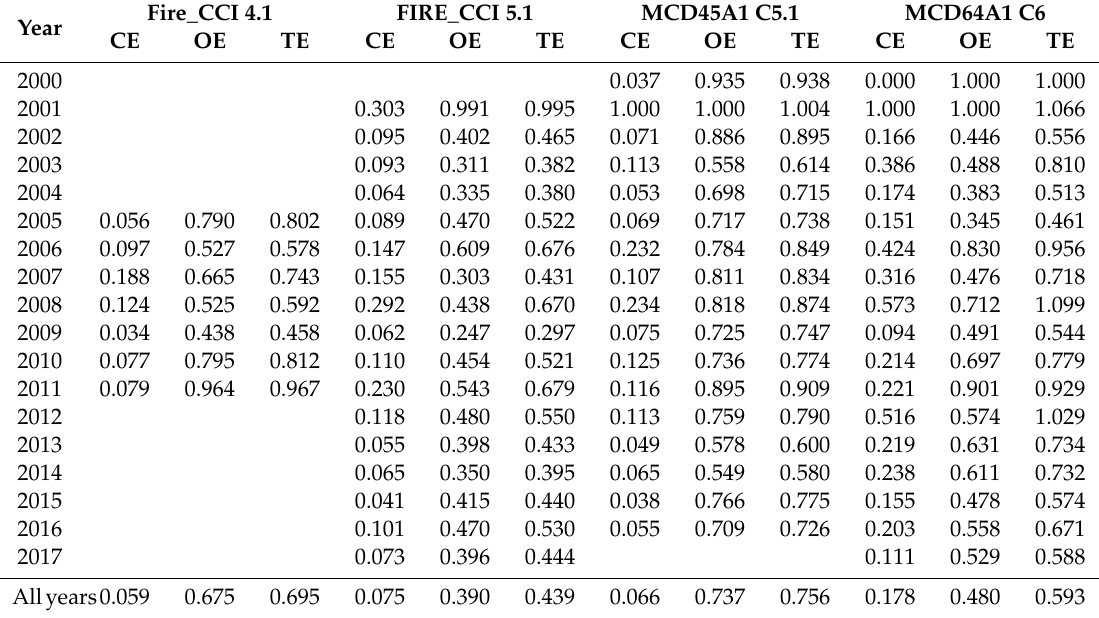
Table 4. Commission (CE), Omission (OE) and Total (TE) errors of the Fire_CCI 4.1, Fire_CCI 5.1, MCD45A1 C5.1 and MCD64A1 C6 burned area products for each year and the weighted average errors (the weights are the annual percentage of BA with respect to total BA) for all years.